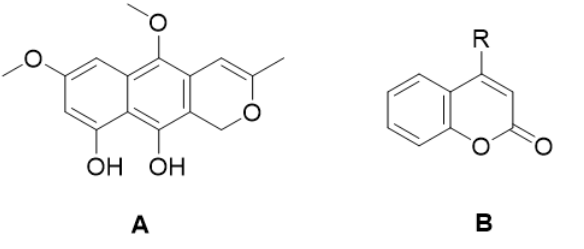
Figure 4. Chemical structure of paepalanthin ( A ) (9,10-dihydroxy-5,7-dimethoxy-1 H - naptho(2,3c)pyran-1-one) and coumarin (R = H) and 4-hydroxycoumarin, R = OH ( B ). Aesculin (7-hydroxy-6- O -glucosylcoumarin) (Figure 5), another coumarin deriva-